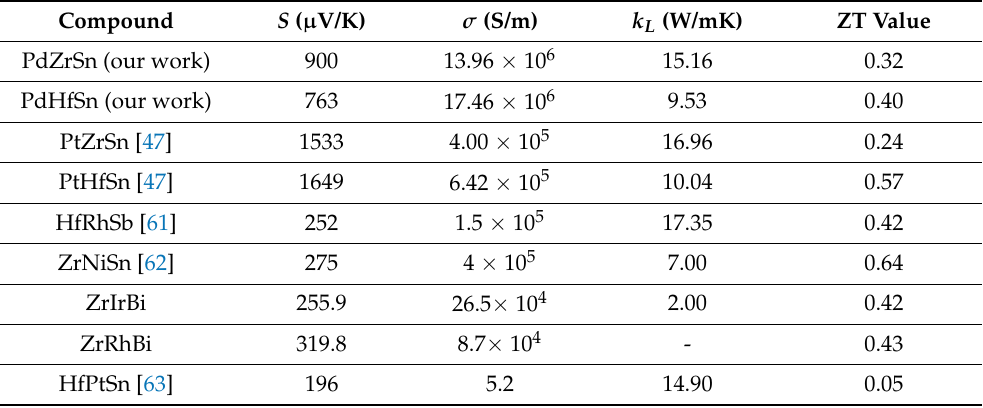
Table 4. Comparison of Seebeck coefficient ( S ), electrical conductivity ( σ ), and thermal conductivity ( k L ) (at 300 K) and maximum ZT of PdXSn (X = Zr, Hf) with other half Heusler